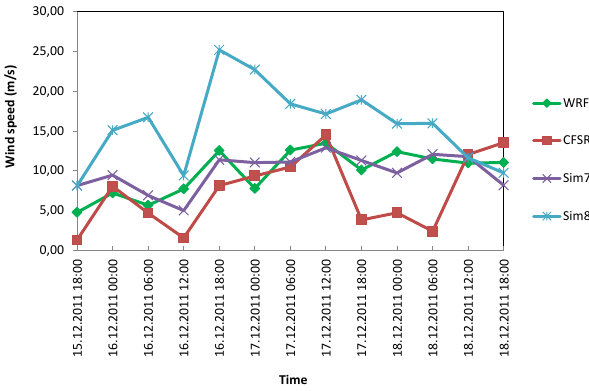
Fig. 8 Comparison wind speed prediction for typhoon Washi by different simulations and data 2 Figure 8. Comparison of wind-speed prediction for typhoon Washi through different simulations and data